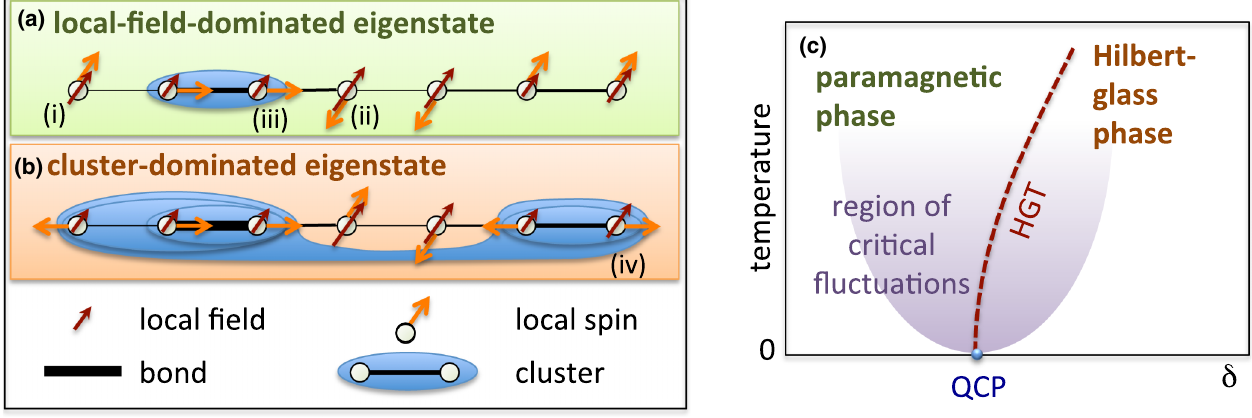
FIG. 1. (a) Schematic representation of a typical eigenstate in the paramagnetic (local-field-dominated) phase: the local spins are largely aligned (i) or antialigned (ii) with the local fields; rare clusters can still be present (iii). (b) Hilbert-glass (cluster-dominated) eigenstate: local spins form magnetic clusters that often contain domain walls; rare isolated spins can still be present. (c) Schematic phase diagram of the Hilbert-glass transition (HGT) in the tuning parameter – temperature plane. The diagram shows the HGT line separating the paramagnetic (local-field-dominated) and the Hilbert-glass (cluster-dominated) phases terminating in a zero-temperature quantum critical point (QCP). The behavior of equilibrium thermodynamic observables at finite temperatures is governed by the QCP in the region of critical fluctuations [15]. While equilibrium thermodynamic observables have no singularities in the phase diagram, with the exception of the zero-temperature QCP, dynamical observables show singular behavior along the HGT